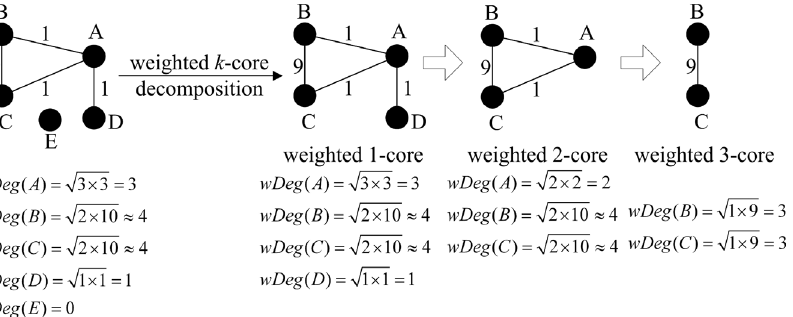
Figure 3. Illustration of the Layered Structure of a Network Obtained Using the Weighted k -Core Decomposition Method. The text at the bottom of the figure denotes the weighted degree of the nodes in the corresponding